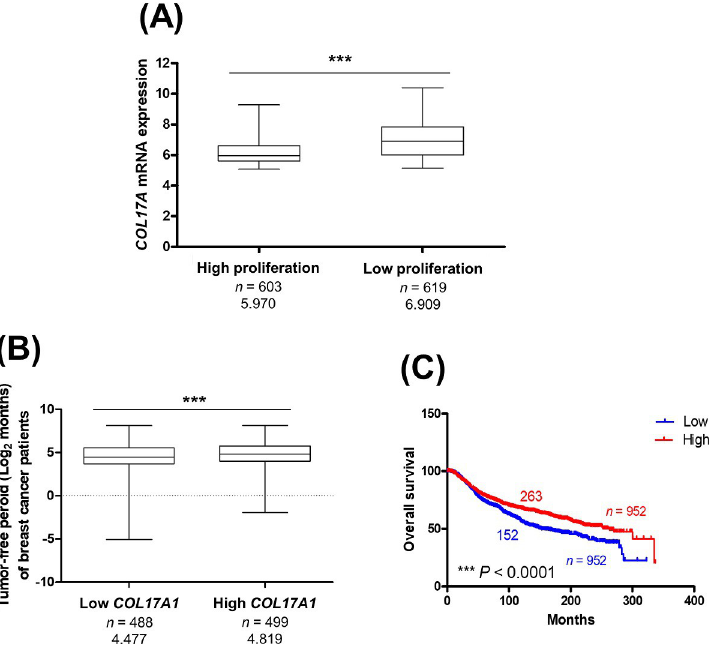
Fig 7. High COL17A1 level is associated with low proliferation and extended tumor progression in patients. The COL17A1 mRNA expression in primary breast cancer and patient clinical data were retrieved from METABRIC study. (A) Boxplot analysis of COL17A1 level in low-proliferation and high-proliferation ER+ HER2 − tumors categorized by 3-gene classifier subtype. (B–C) The COL17A1 level was categorized as low and high expression comparing to median expression. Tumor-free period (B) and overall survival (C) of patients bearing tumors with high and low level of COL17A1 were analyzed. Log-rank test was used for survival analysis. Mann − Whitney U -test was used for boxplot. ��� P < 0.0001.